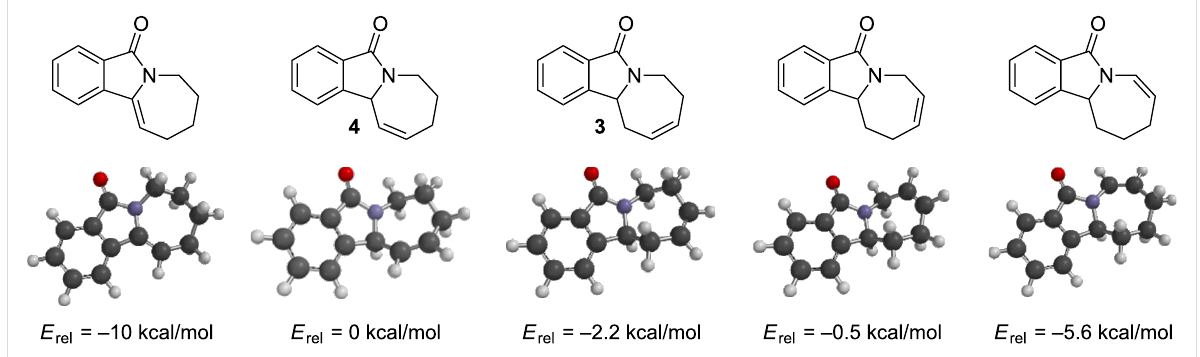
Figure 3: Relative energies of alkene isomers based on RB3LYP/6-311G* calculations with MacSpartan ’06.